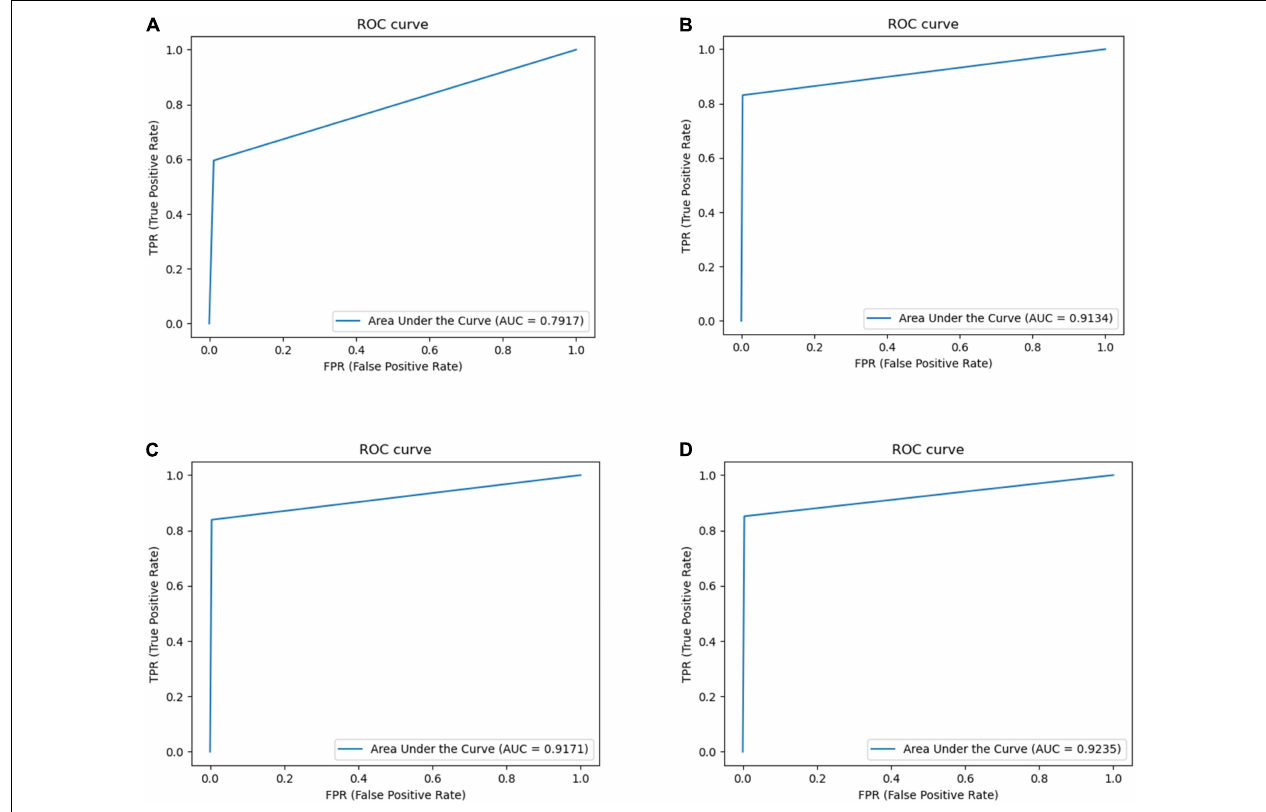
FIGURE 8 | Experimental ROC curve diagram: (A) Unet (AUC = 0.7917); (B) VGG network (AUC = 0.9134); (C) ResNet (AUC = 0.9171); (D) Res2Net (AUC = 0.9235).